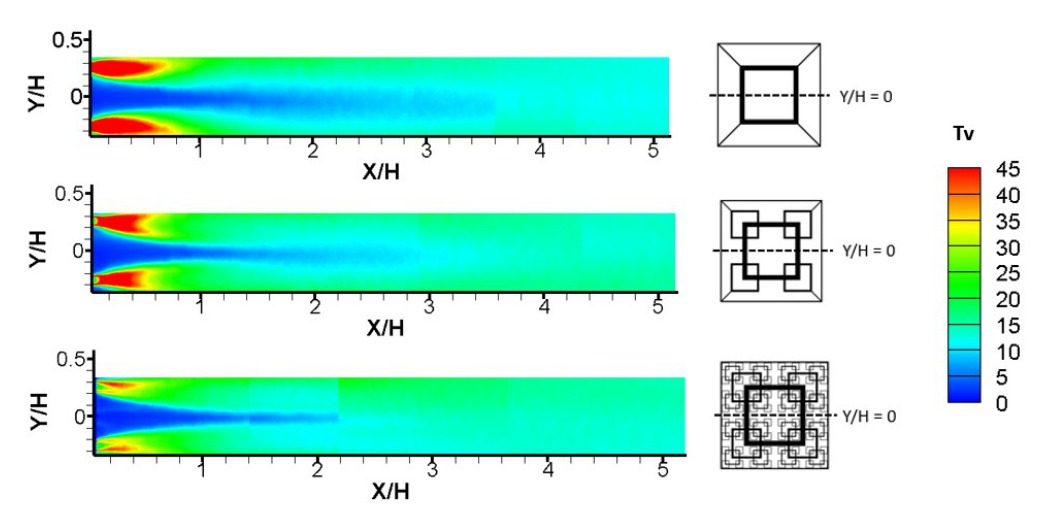
Figure 8. Vertical turbulence intensity T v (%) downstream of a fractal square grid at Re = 3400. FG1, FG2 and FG4 from top to bottom.